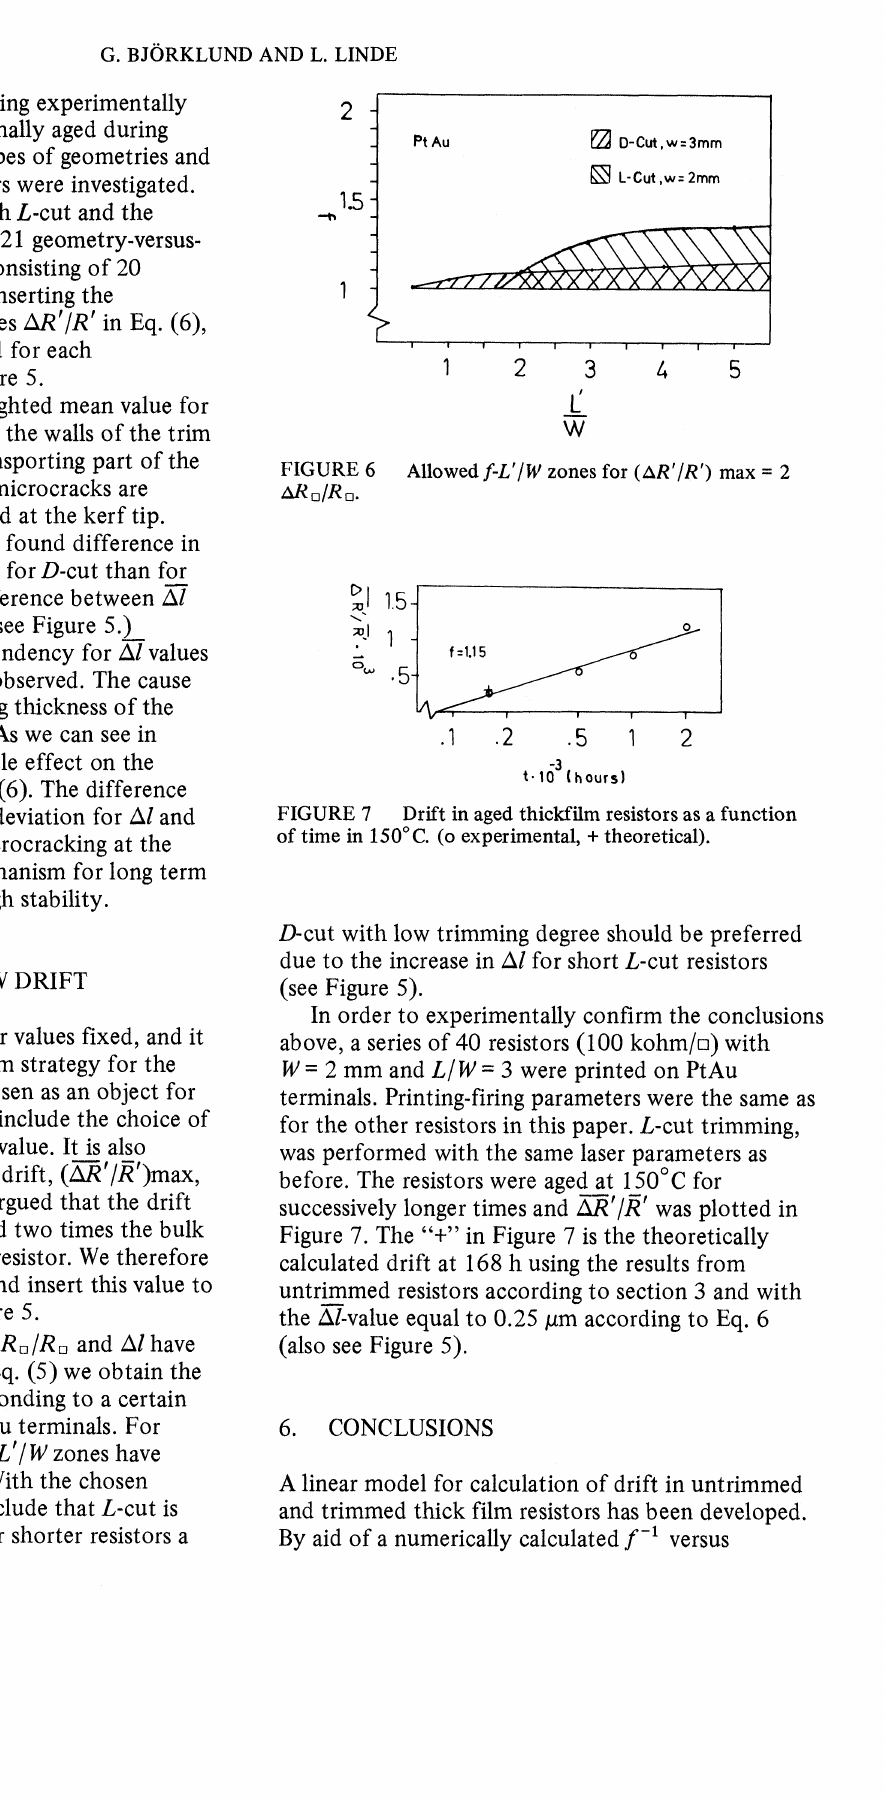
Figure 7. The "+" in Figure 7 is the theoretically calculated drift at 168 h using the results from untrimmed resistors according to section 3 and with the A/-value equal to 0.25/am according to Eq.